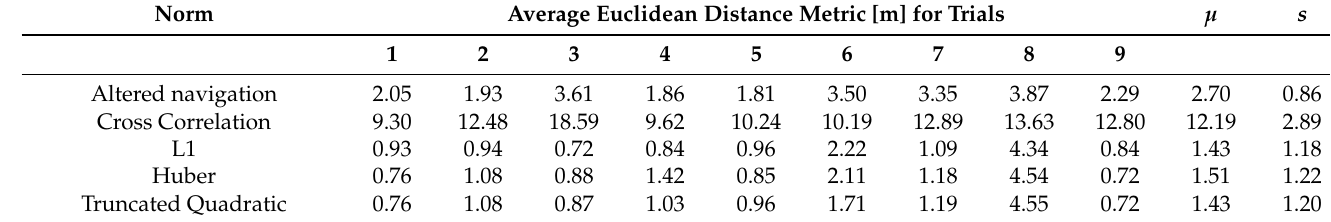
Figure 8. Original and altered navigation alongside the renavigated solution centered towards the original navigation using cross correlation. Table 4. Average Euclidean distance of ground truth navigation to altered navigation and renavigated solutions for different norms based on nine different altered navigations. The values are rounded to two places after the decimal